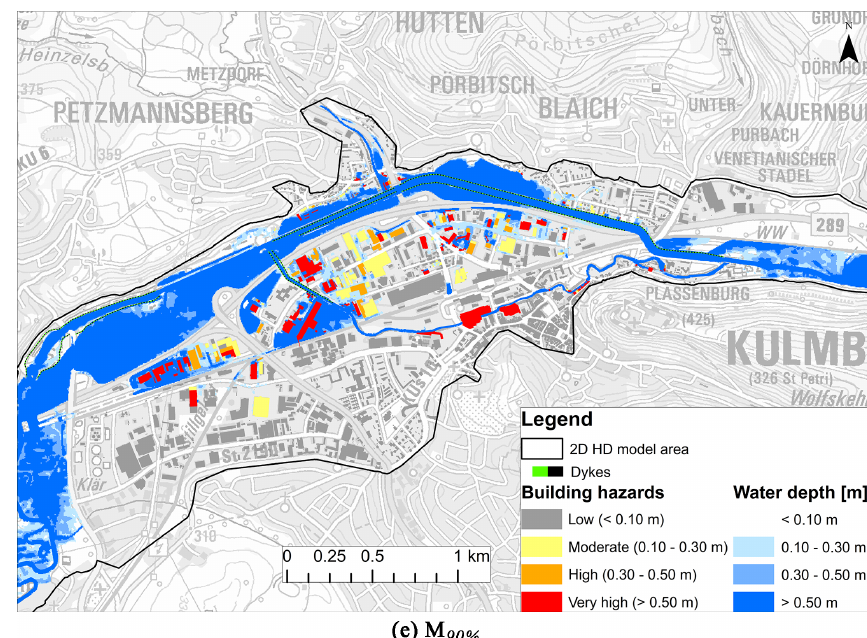
Figure 7. Flood inundation and building hazard maps for five-percentile discharge hydrographs. (Data source: Geobasisdaten © Bayerische Vermessungsverwaltung, http://www.geodaten.bayern.de, last access: 5 March